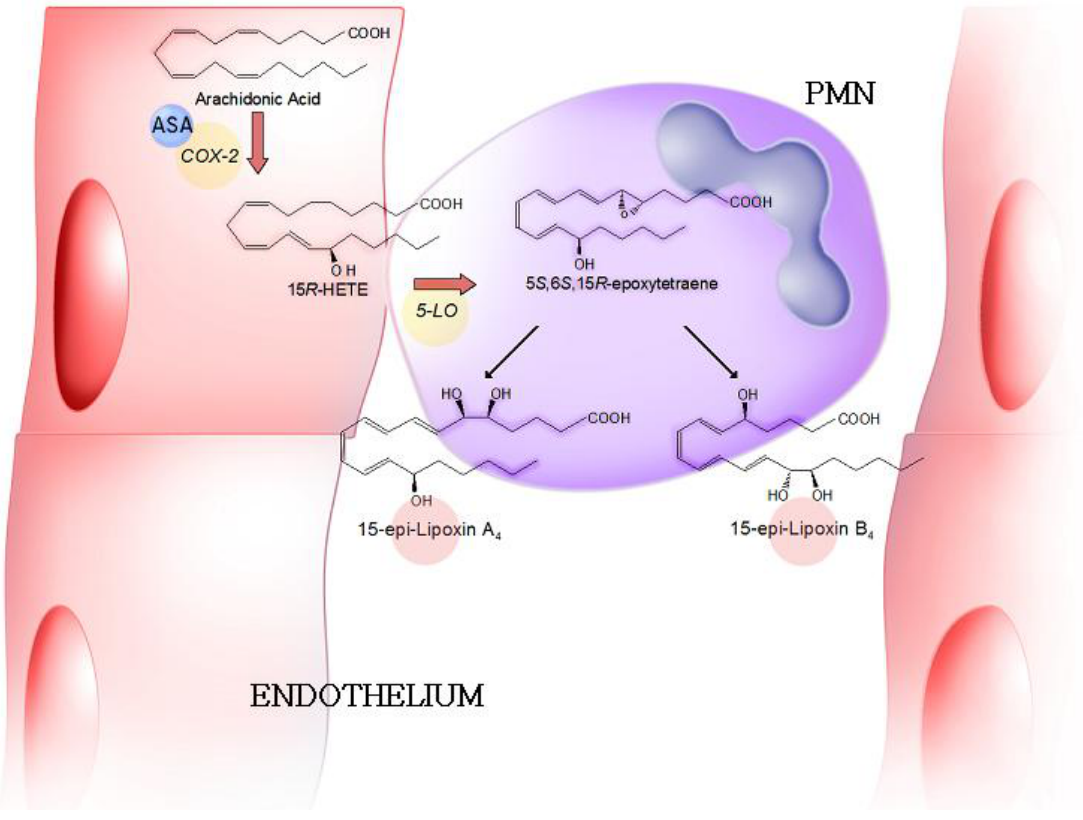
FIGURE 4. ATL biosynthetic pathway during interactions between aspirin-treated endothelial cells and